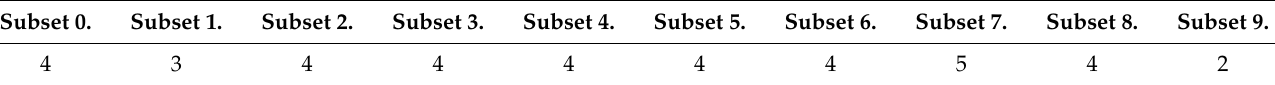
Figure 10. Plot for within ‐ cluster ‐ sum of squared errors for k. Table 7. Optimal k for each subset.